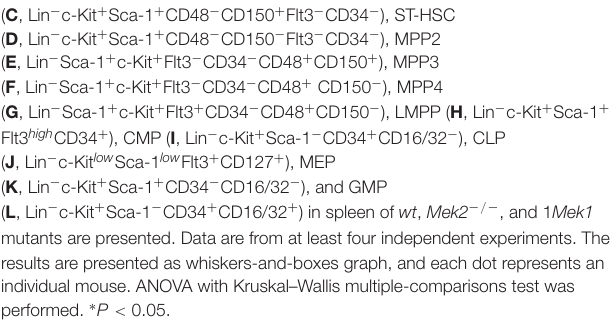
Supplementary Figure 1 | Flow cytometry gating strategy for delineating the major classes of mouse hematopoietic stem and progenitor cells. Representative dot plots show the flow cytometry gating strategy used for LSK (Lin − c-Kit + Sca-1 + ), SLAM (LSK CD48 − CD150 + ), LT-HSC (LSK